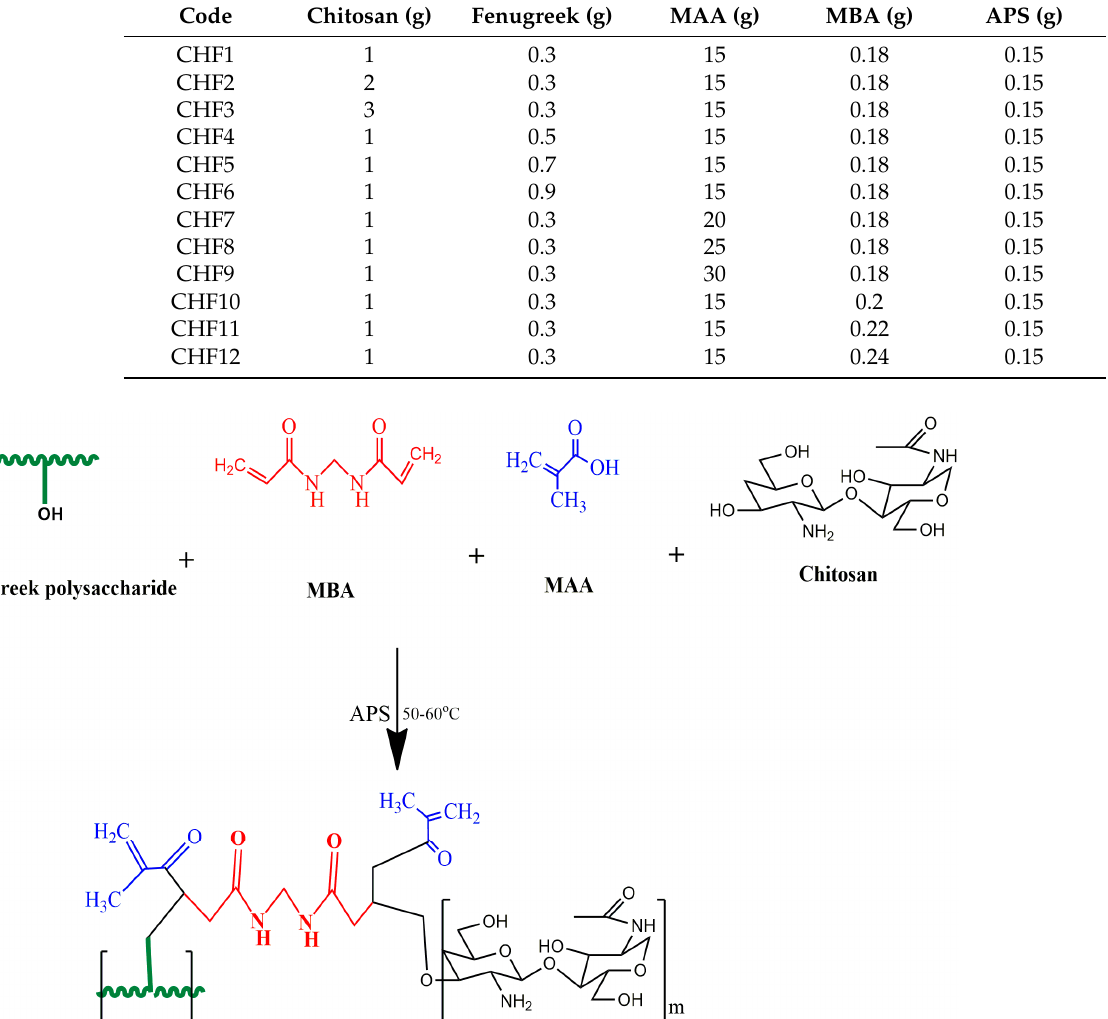
Table 7. Composition of Chitosan/Fenugreek-g-poly (MAA) Hydrogels.